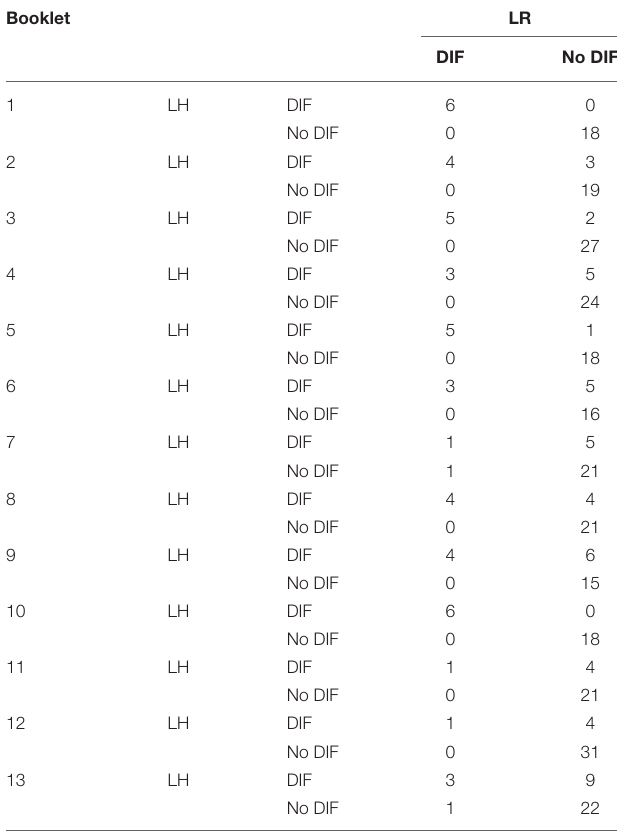
TABLE 4 | Number of DIF items identified by both IRT and LR DIF